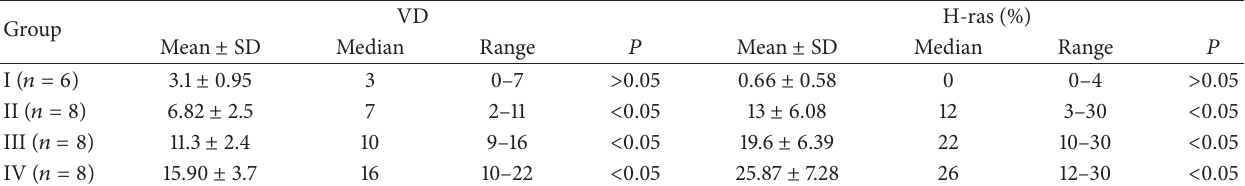
Table 1: Distribution of mean, standard deviation (SD), median, and ranges of vascular density (VD) and H-ras expression in normal livers (group I), nonfibrotic (group II), fibrotic (group III), and cirrhotic livers (group IV). The Mann-Whitney 𝑈 test was used. VD H-ras (%) Group Mean ± SD Median Range 𝑃 Mean ± SD I ( 𝑛 = 6 ) 3.1 ±